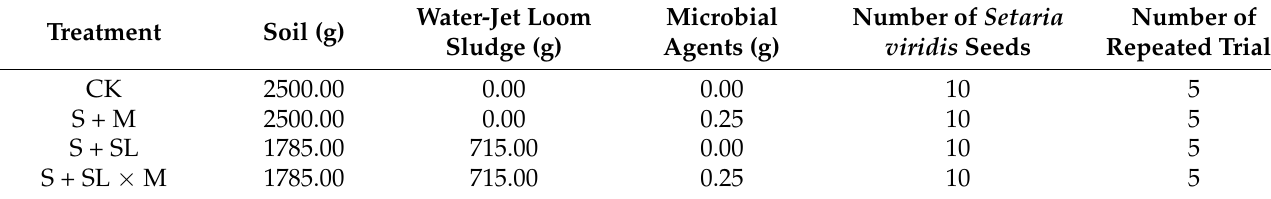
Table 1. Pot trial